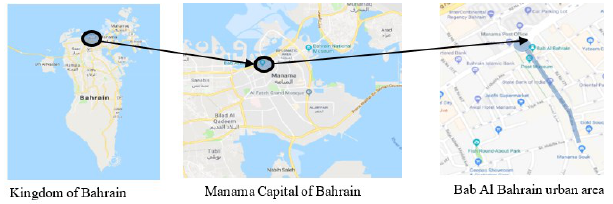
Figure 5. Bab Al Bahrain location in the beginning of the busiest streets in Manama.